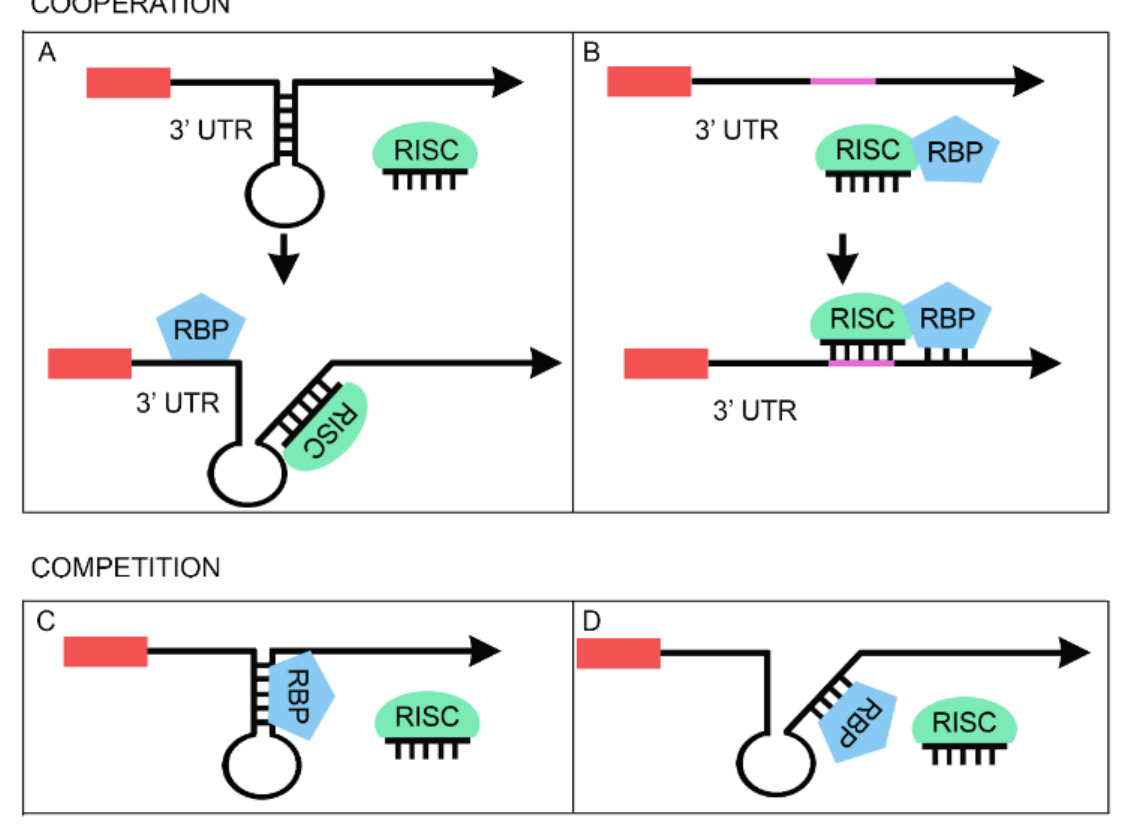
Figure 2. Functional interaction between microRNAs and RBPs. Upper panel: cooperative model. The RBP can enhance the miRNA effect on the common mRNA target by opening the RNA secondary structure ( A ). Alternatively, the RBP can improve the transport of the miRNA loaded in the RISC complex to its target ( B ). Lower panel: competitive